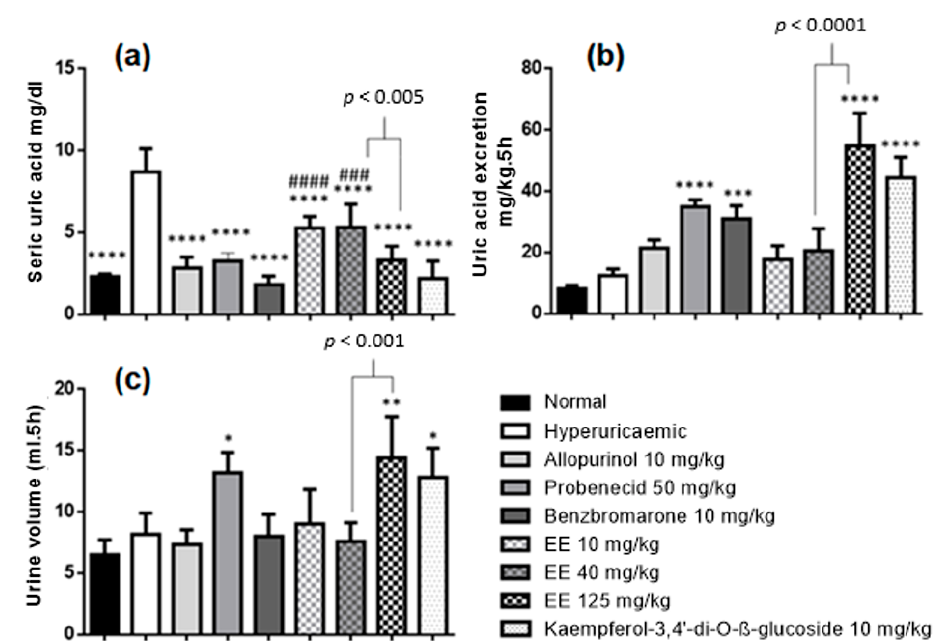
Figure 4. Biological effects in hyperuricaemic Wistar rats after treatments with E. sativa ethanolic extracts and positive controls allopurinol, probenecid and benzobromarone ( a ) Seric concentrations of uric acid ( b ) Excretion of uric acid ( c ) Urine volume excreted after 5 h of the treatment. *** p < 0.001 vs. hyperuricaemic control group; ### p < 0.001 vs. normal control group; #### p < 0.0001 vs. normal control group; **** p < 0.0001 vs. hyperuricaemic control group; *** p < 0.001 vs. hyperuricaemic control group; ** p < 0.01 vs. hyperuricaemic control group; * p < 0.05 vs. hyperuricaemic control group ( n = 6, One ‐ way ANOVA followed by the Dunnet test).